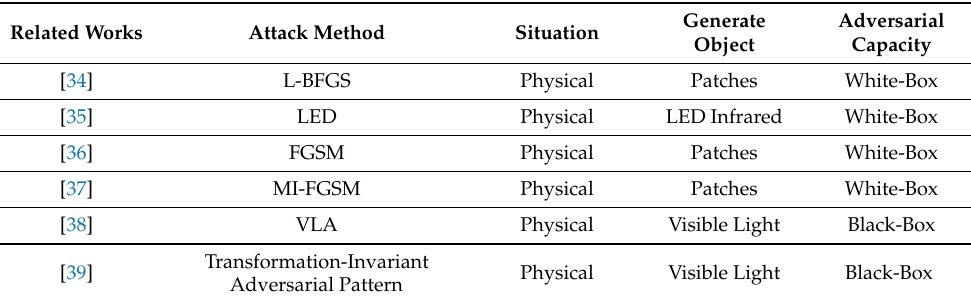
Table 2. Related